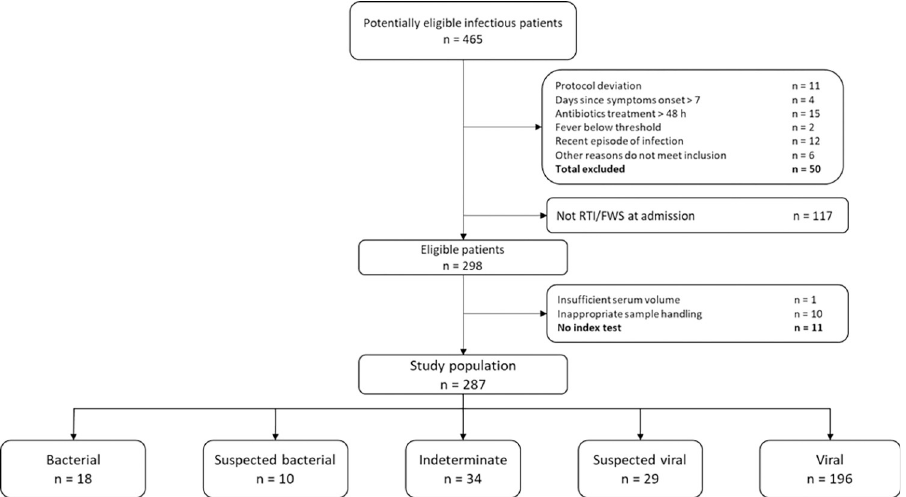
Fig 1. Patient enrollment flow. Summary of patients enrolled in the study. Primary (bacterial/viral) cohort (n = 214) includes reference standard bacterial (n = 18) and reference standard viral (n = 196). Secondary